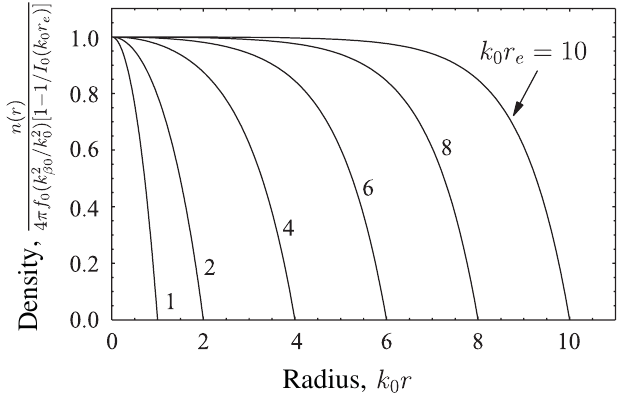
FIG. 10. For a waterbag equilibrium, the scaled density profile n ð r Þ = f 4 (cid:6)f radial coordinate k values of k